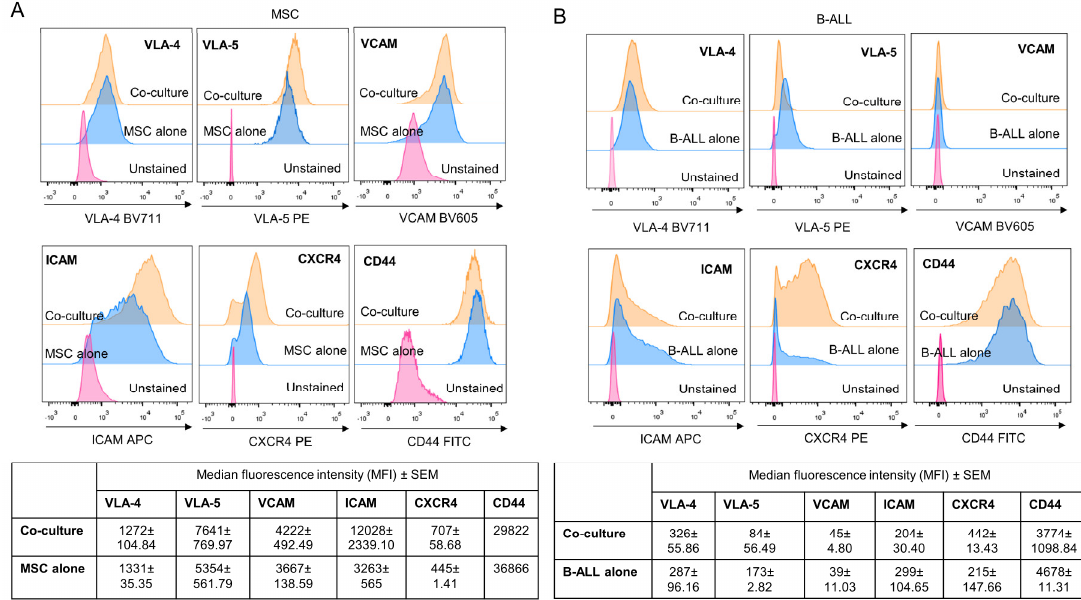
Figure 6. Cell to cell interaction promotes changes in the expression profile of different adhesion molecules in MSC and B-ALL cell populations. ( A ) A representative experiment showing the expression of VLA-4, VLA-5, VCAM, ICAM-1, CXCR4, and CD44 by flow cytometry in MSC alone or in co-cultures with B-ALL cells stablished for 6 h. ( B ) Unattached B-ALL cells and B-ALL cells recovered from the co-culture were labelled for assessing the expression of the indicated molecules. Data are expressed as mean of MFI ± SEM obtained from three independent experiments.